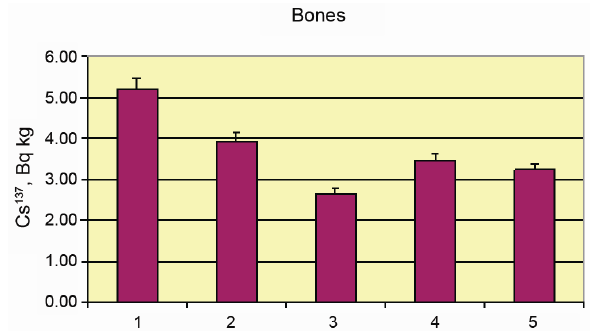
40 K in fox muscle: